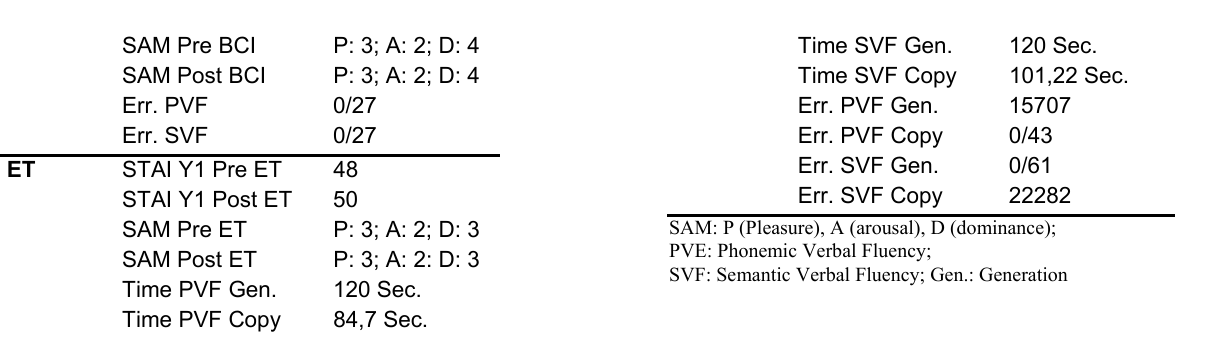
Table 3 . ALS patient scores on ET and BCI usability